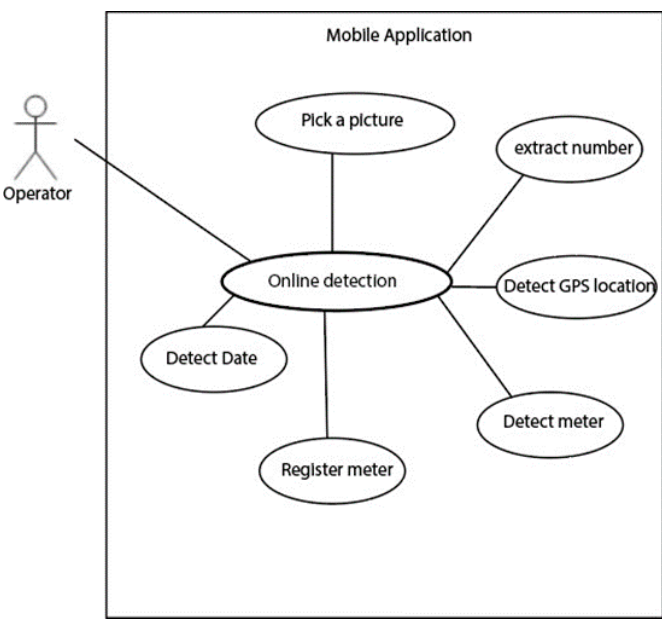
Figure 3. General use case diagram.